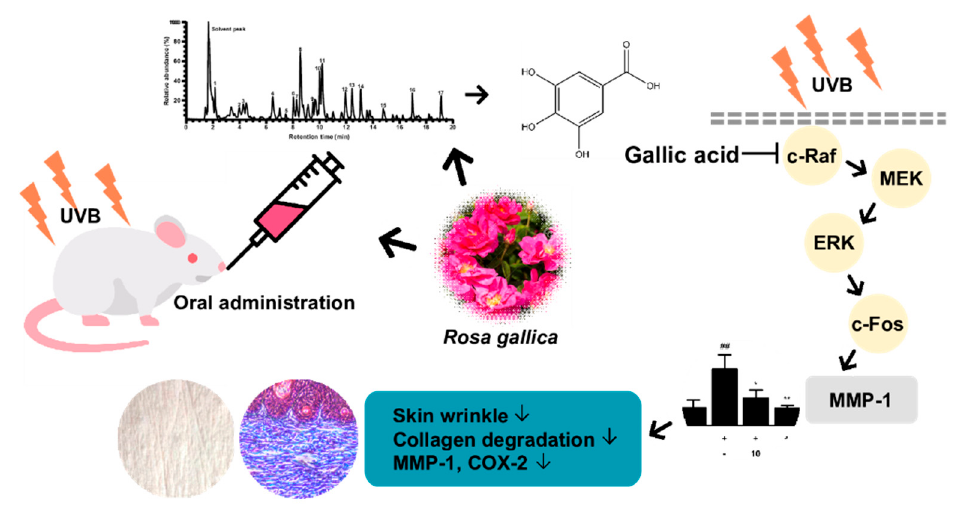
Figure 8. Schematic diagram summarizing the anti − skin aging effect of Rosa gallica and its mecha- nism.